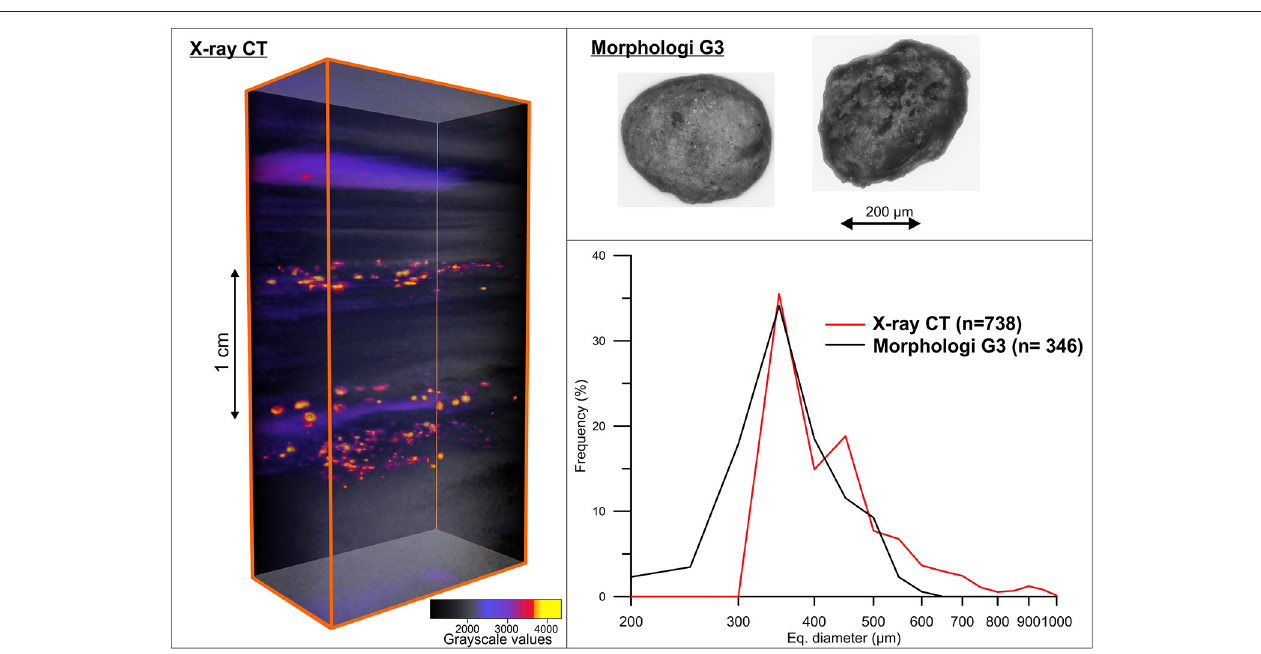
FIGURE 5 | Selected interval from VAP114 visualized by the X-ray CT. Here, the grayscale threshold is set to highlight the sand-sized particles obtained using the 99th percentile of the grayscale values, i.e., the less dense material is not shown (background deposits). Upper right: Two examples, from selected intervals in VAP114 (95cm and 122cm), of the particles measured by the Morphology G3. Lower right: A comparison of the frequency (percentage) of particle sizes counted by the X-ray CT and measured by the Morphologi G3. Note logarithmic